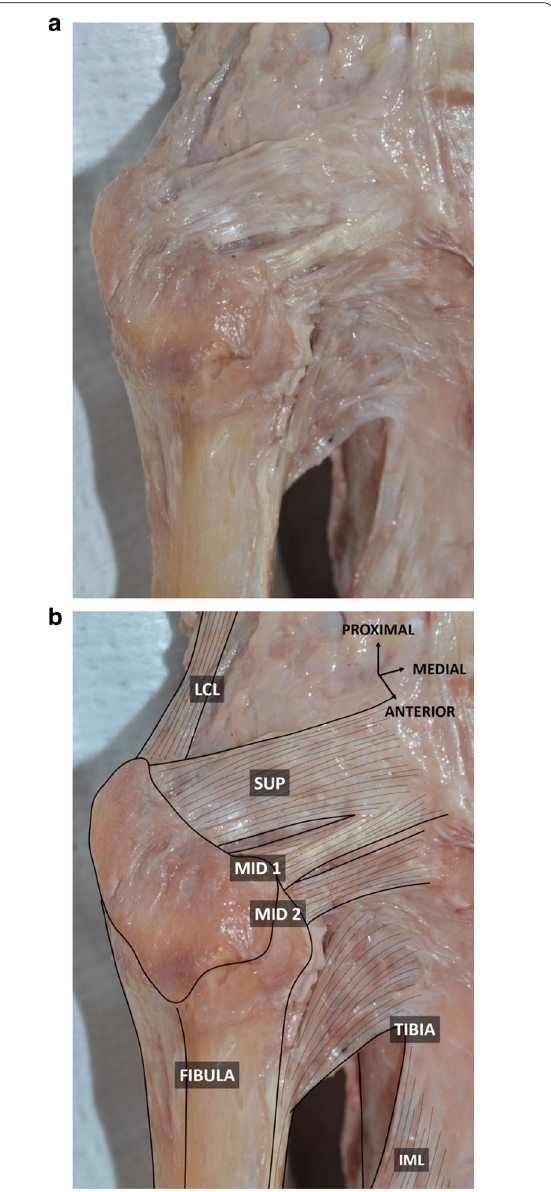
Fig. 2 Anterolateral view of the proximal tibiofibular joint without ( a ) and with ( b ) annotations. Muscular structures have been removed, exposing the underlying anterior PTF ligament. SUP: superior bundle of the anterior PTF ligament; MID 1: upper middle bundle of the anterior PTF ligament; MID 2: lower middle bundle of the anterior PTF ligament. LCL: lateral collateral ligament; IML: interosseous membrane of the